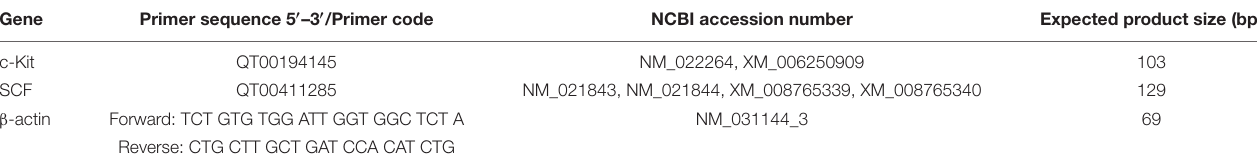
TABLE 2 | Sequence and code for primers of targeted and housekeeping genes. Gene Primer sequence 5 (cid:48) –3 (cid:48) /Primer code NCBI accession